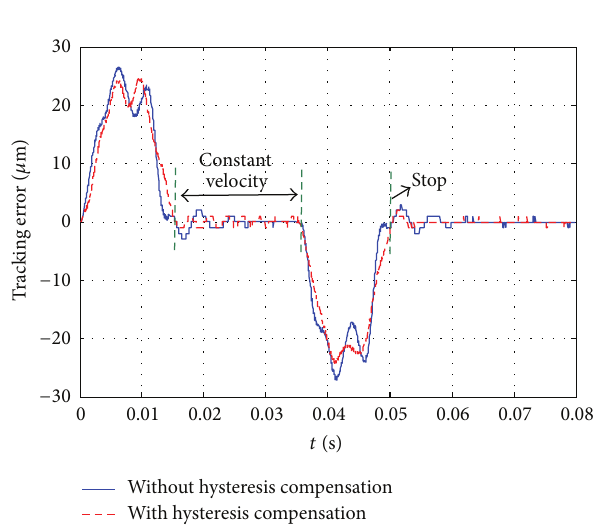
Figure 11: Comparison of the position tracking.